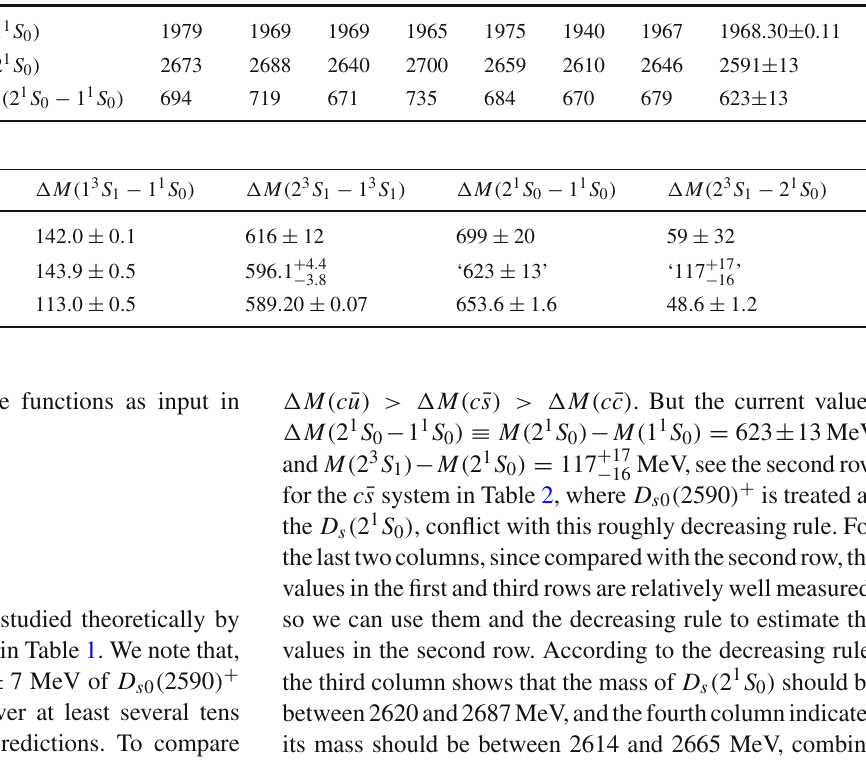
Table 1 Masses of D s ( 1 1 S 0 ) , D s ( 2 1 S 0 ) and their mass splitting in unit of MeV